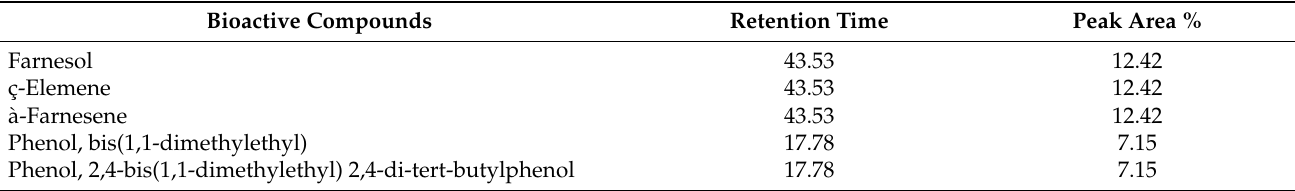
Table 2. Gas Chromatography–Mass Spectrometry (GC–MS) Analysis of